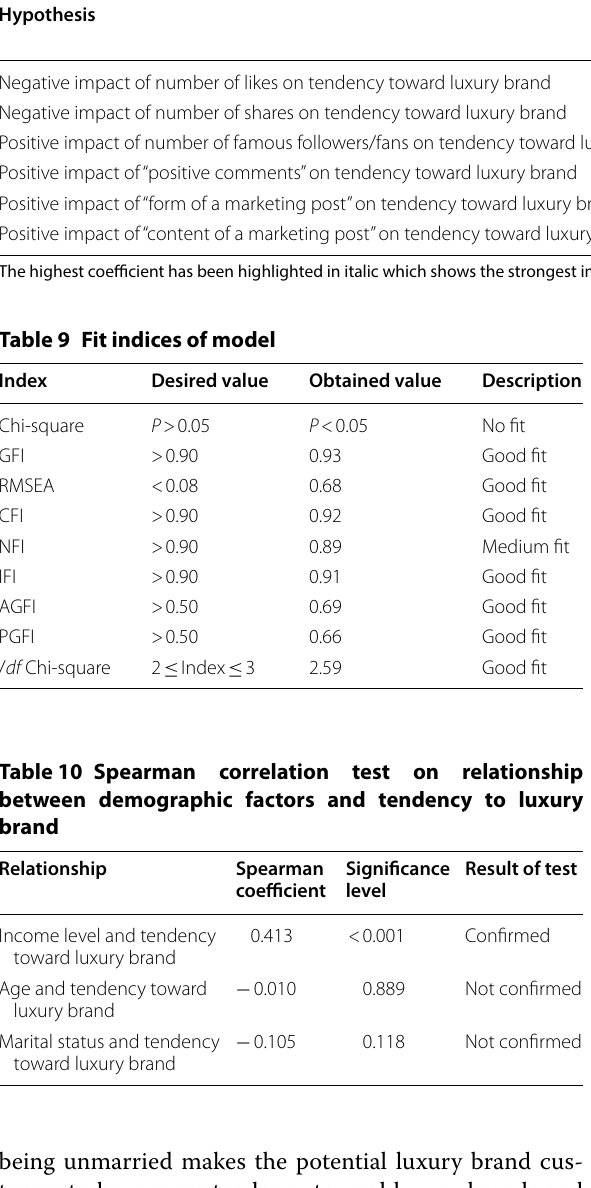
Table 8 Results of testing the model, standardized coefficients